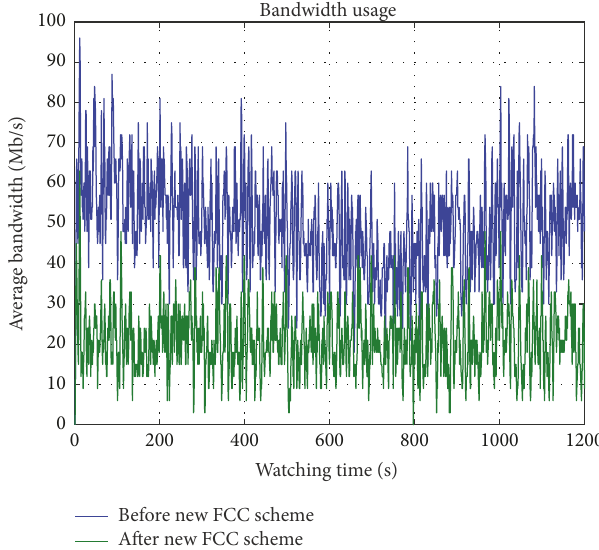
Figure11:FCCbandwidthusagebeforeandafterusingthenewFCC